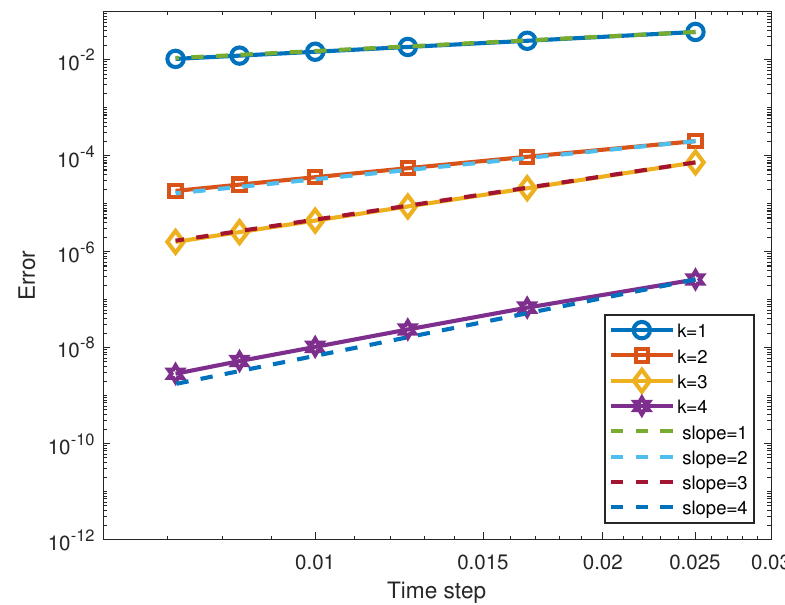
Figure 3. Errors of k -step exponential multistep method for problem (24). k = 1,2,3,4. D 1 = a 1 = b 1 = r 2 = b 2 = a 2 = 1, D 2 = r 1 = 2.